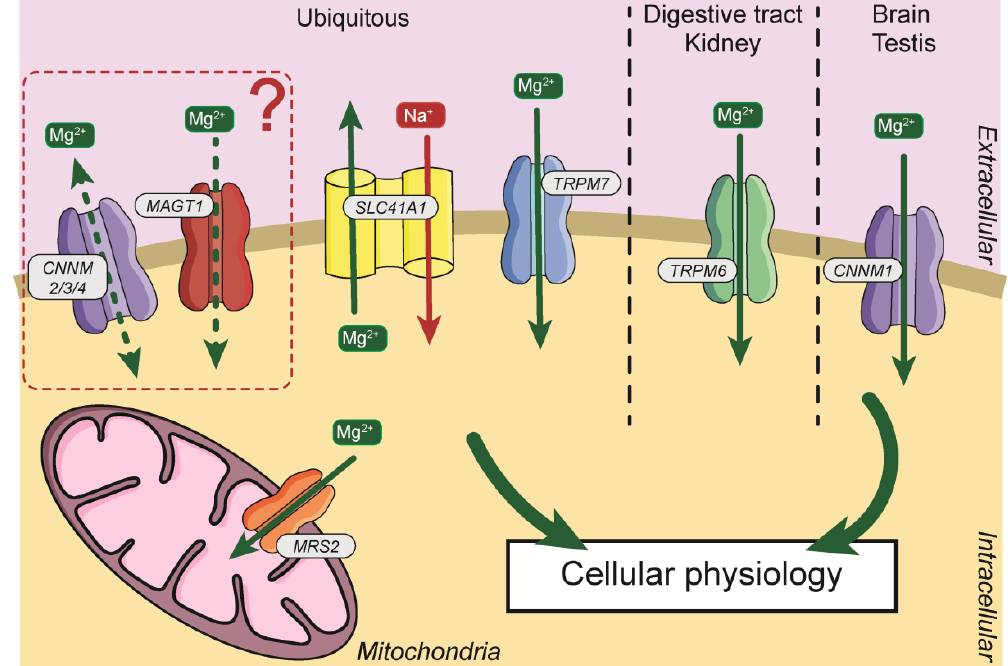
Figure 2. General distribution and localization of Mg 2+ transporters in cells. Mg 2+ , magnesium; Na + , sodium; CNNM2/3/4, Cyclin and CBS Domain Divalent Metal Cation Transport Mediator2/3/4; MAGT1, Magnesium Transporter 1; SLC41A1, Solute Carrier Family 41, Member 1; TRPM7, Transient Receptor Potential Cation Channel Subfamily M Member 7; TRPM6, Transient Receptor Potential Cation Channel Subfamily M Member 6; CNNM1, Cyclin and CBS Domain Divalent Metal Cation Transport Mediator1; MRS2, Mitochondrial RNA Splicing Protein 2.